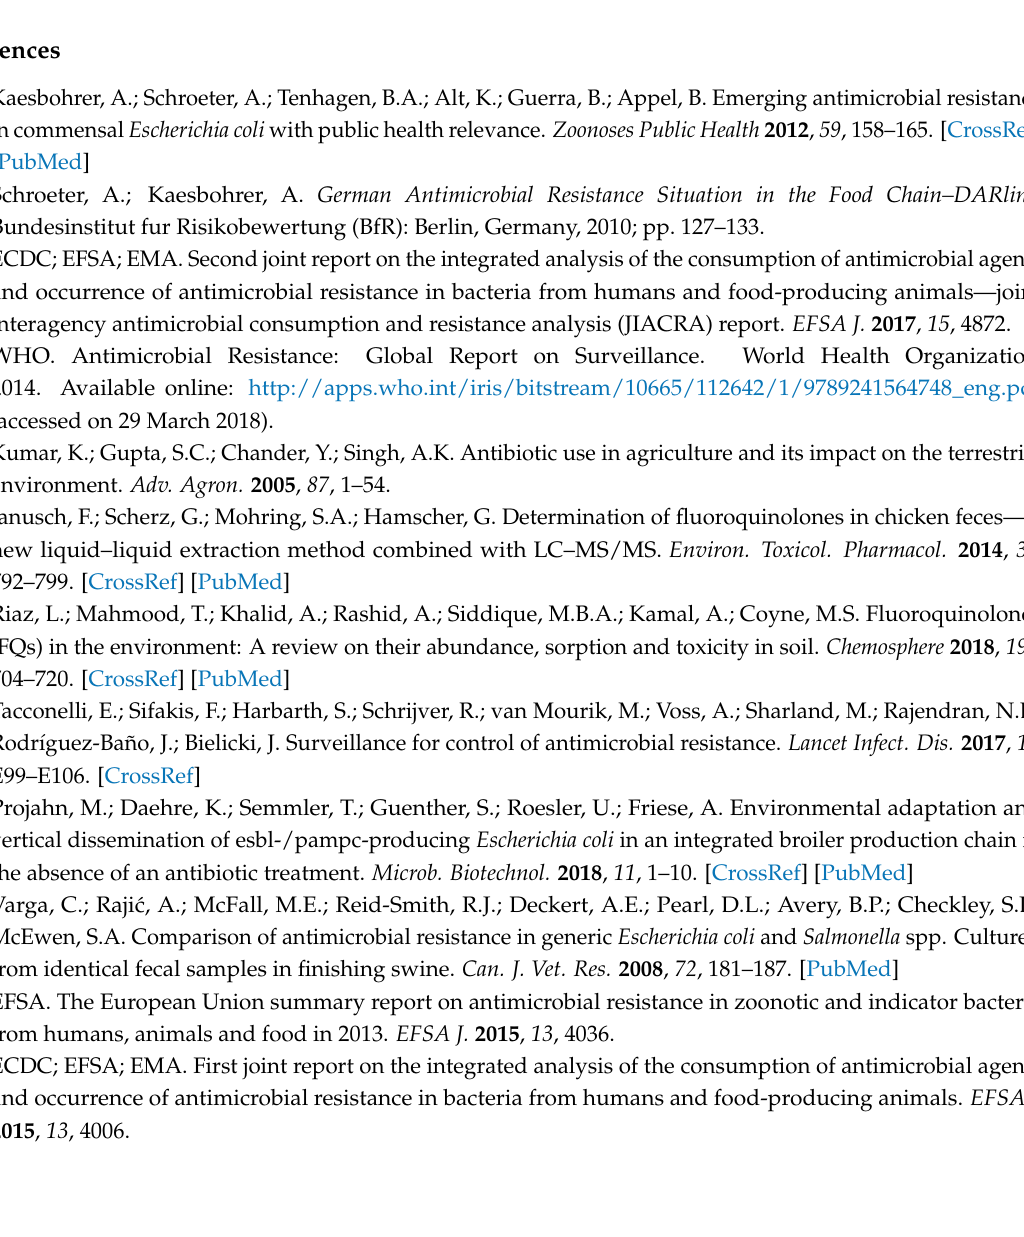
s1, Table S1a: Means of enrofloxacin- resistant E. coli isolates from cloacal swab and manure samples from turkeys, Table S1b: Means of ampicillin-resistant E. coli isolates from cloacal swab and manure samples from